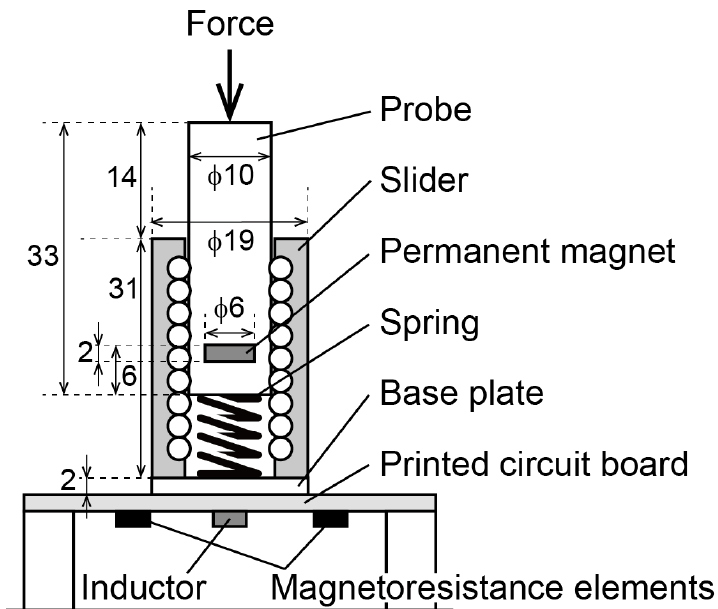
Figure 1. Cross-sectional view of the texture